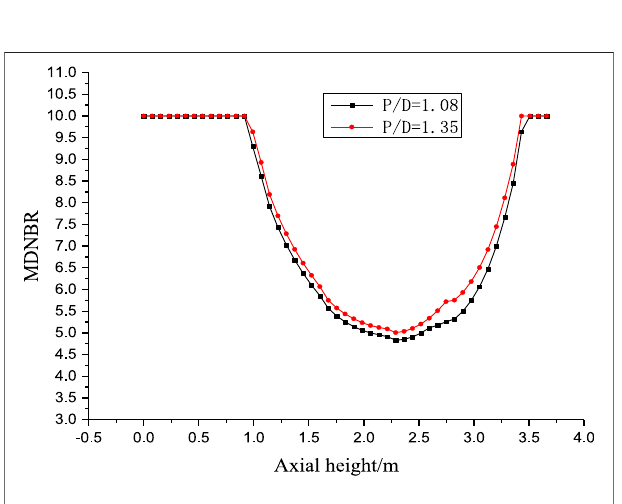
FIGURE 9 | Outlet temperature distribution change before and after considering the tight lattice